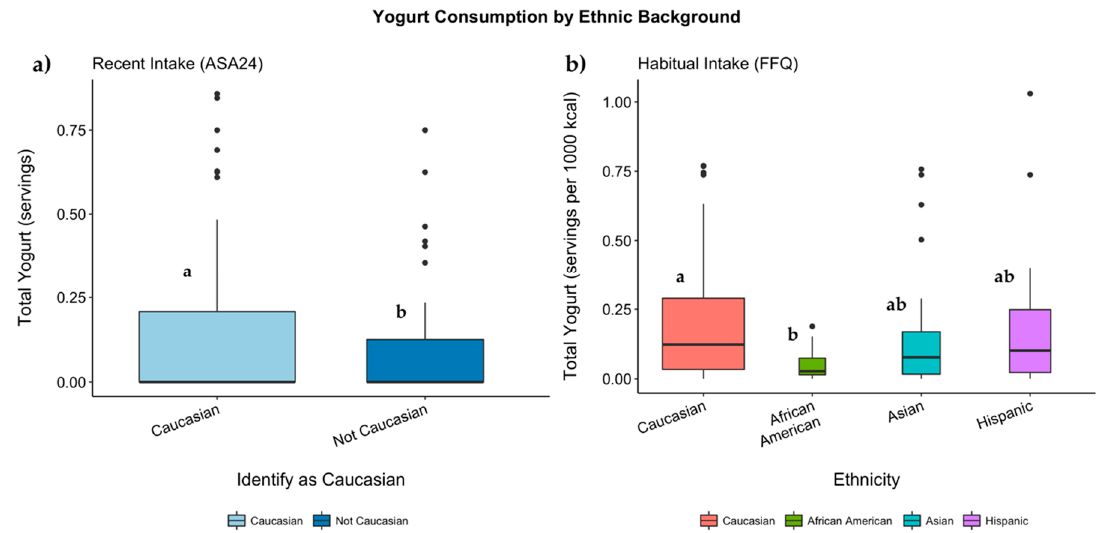
Figure 4. Boxplot of all subjects for yogurt for ( a ) recent intake measured via the ASA24 recalls and for ( b ) habitual intake measured via the FFQ. Box width is scaled to the number of subjects. p values were calculated using ordinal logistic regression. Adjustment for multiple comparisons was performed using the Tukey adjustment. Groups without a common letter differ significantly ( p < 0.05).